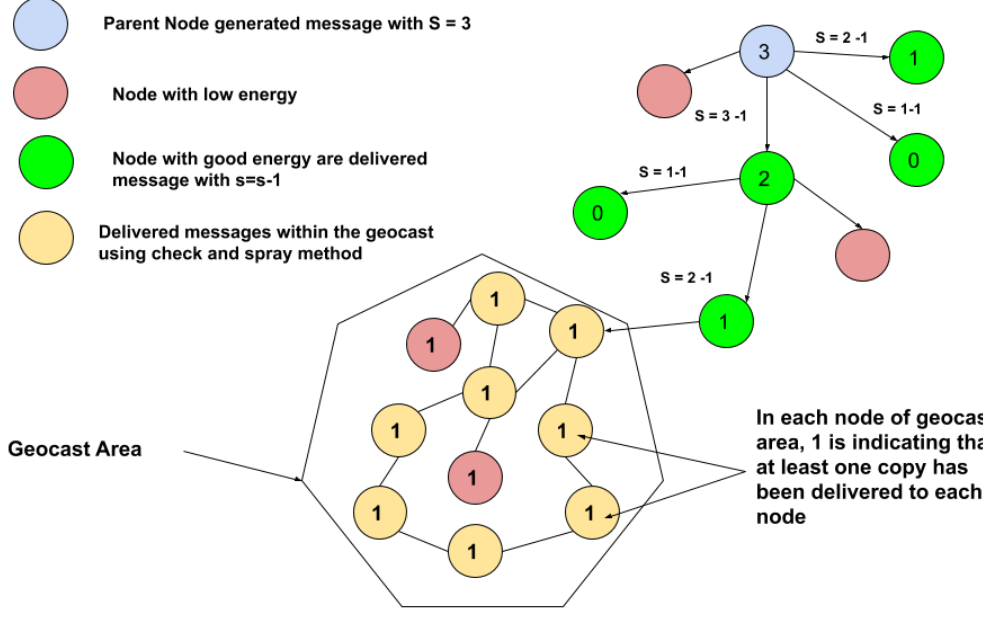
Figure 1. Energy-Efficient Check-and-Spray Geocast Routing (EECSG) pictorial